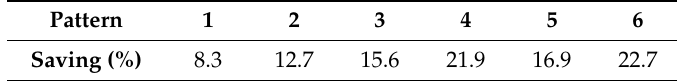
Table 4. Energy savings provided by the multilevel adaptive control when compared with the control with fixed